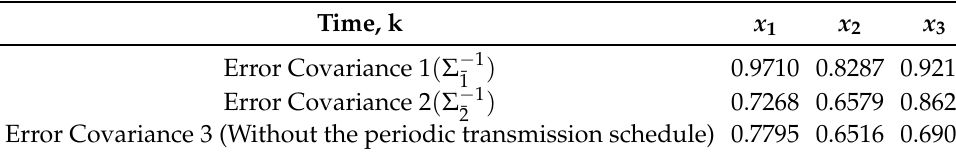
Table 1. The values of error covariances in the above